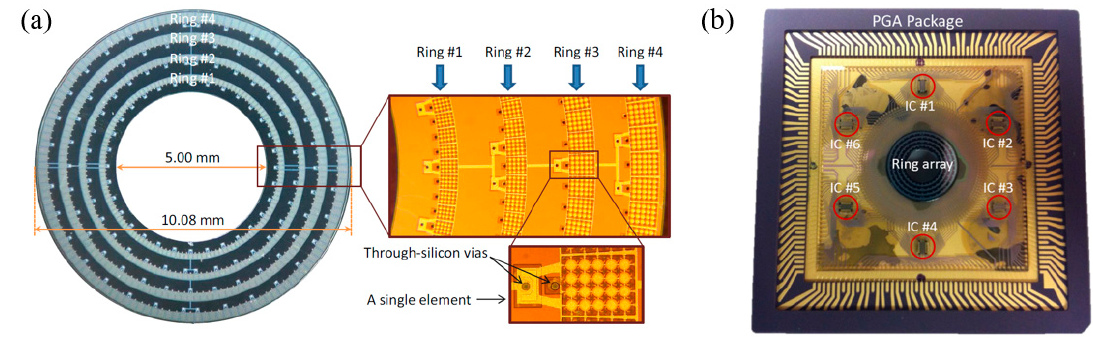
Figure 27. Optical pictures of the 512-element ring cMUT array ( a ) and the cMUT array integrated with custom front-end electronics in a PGA package ( b ) (Reproduced with permission from IEEE